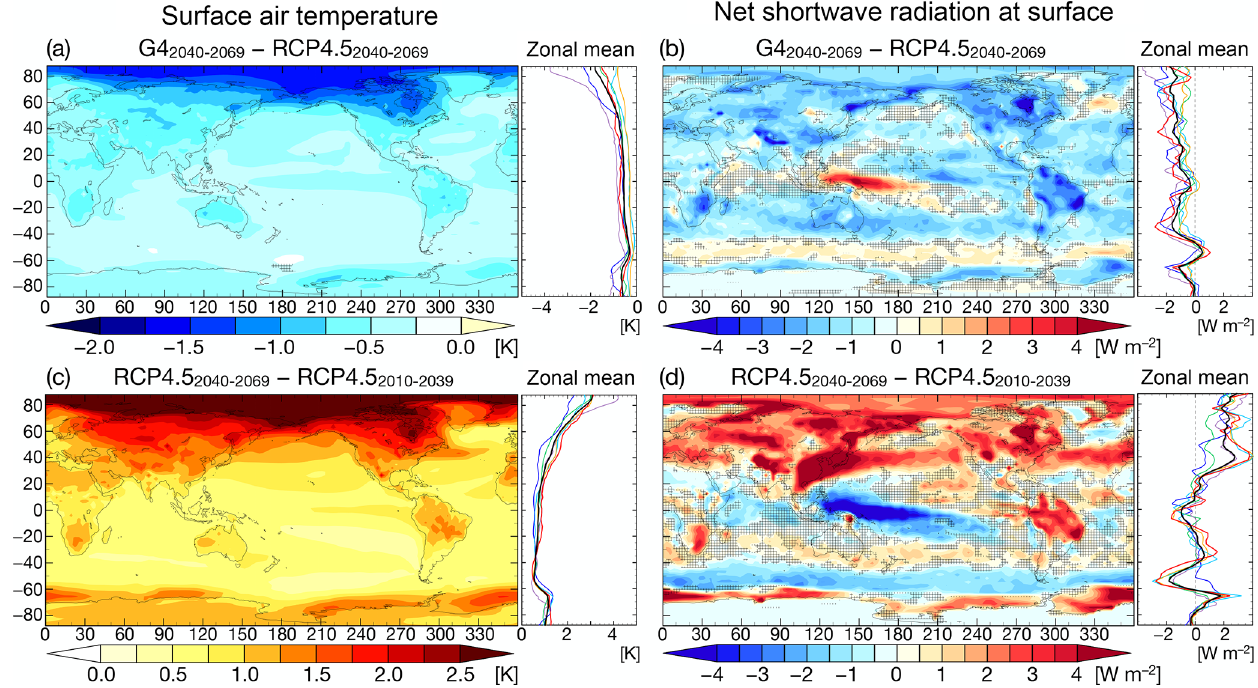
Figure 8. Multi-model mean of difference in the surface air temperature and net shortwave radiation at the surface. (a) and (b) show the difference between G4 and RCP4.5 averaged over 2040–2069. (c) and (d) show the difference between RCP4.5 averaged over 2040–2069 and that over 2010–2039. The colour shading shows the horizontal distribution of the multi-model mean and the black thick line on the right- hand side shows the zonal mean of the multi-model mean. Other coloured thin lines display the ensemble mean (or the result of the single run) of each model (blue: BNU-ESM; green: CanESM2; purple: HadGEM2-ES; cyan: MIROC-ESM; orange: MIROC-ESM-CHEM; red: MIROC-ESM-CHEM-AMP). Hatching indicates the region where two or more models (out of six) disagreed on the sign of the difference. Note that the multi-model mean is calculated by averaging ensemble means (or single run for models that has no ensembles) of the six models. That is, in the multi-model mean, each run of a model is weighted by the reciprocal of the ensemble number of the